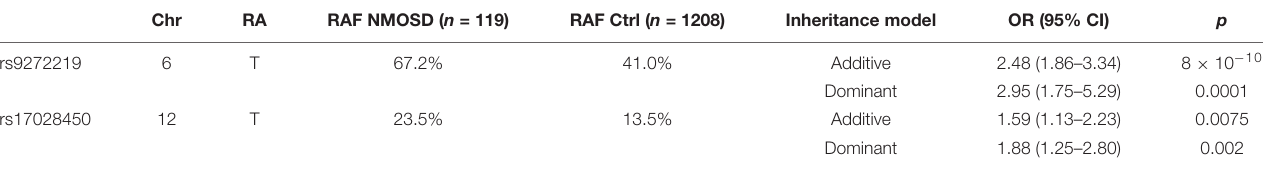
TABLE 1 | Association of HLA rs9272219 and TMPO rs17028450 with NMOSD in the Mexican Population. Chr RA RAF NMOSD ( n =